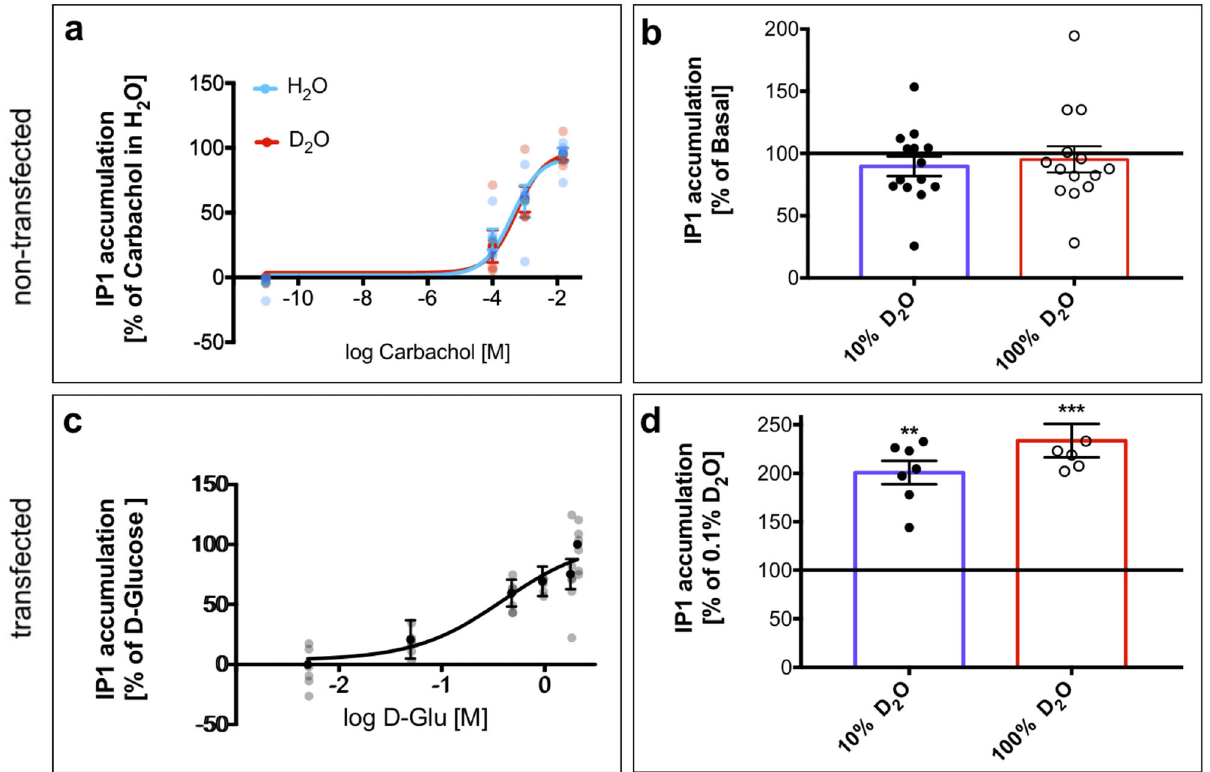
Fig. 6 IP1 accumulation in HEK 293T cells following exposure to different ligands dissolved in powder-based DMEM medium. a Non-transfected HEK 293T cells respond similarly to raising concentrations of carbachol dissolved in D 2 O (red) as in H 2 O (blue). b D 2 O caused no elevation of IP1 levels in non- transfected HEK 293T cells. c HEK 293T cells transiently expressing TAS1R2/TAS1R3 respond positively to D-glucose. d Transfected HEK 293T cells are activated by D 2 O. Values represent the mean ± SEM of at least three replicates. The horizontal black line represents the basal values of controls. Signi fi cant differences in IP1 values from control values are marked with ** p ≤ 0.005 and *** p ≤ 0.0005 using Dunnett ’ s multiple comparisons